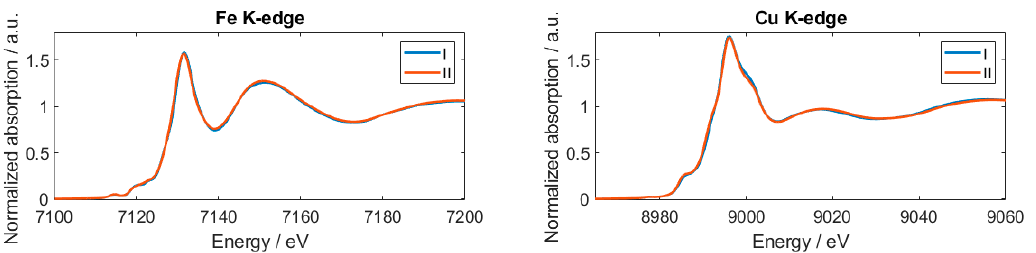
Figure 2. XANES traces at Fe and Cu K-edges for both samples I and II. Spectra were recorded on as-synthesized powders.